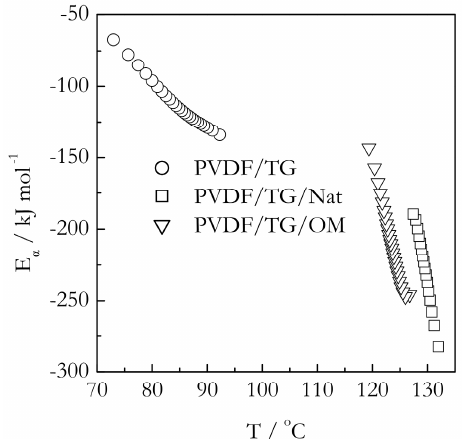
Figure 9. Temperature dependence of activation energy for gelation of PVDF/TG in bulk (circles) and confined systems PVDF/TG/Nat (triangles) and PVDF/TG/OM (squares). Confinement is to 9 nm pores.